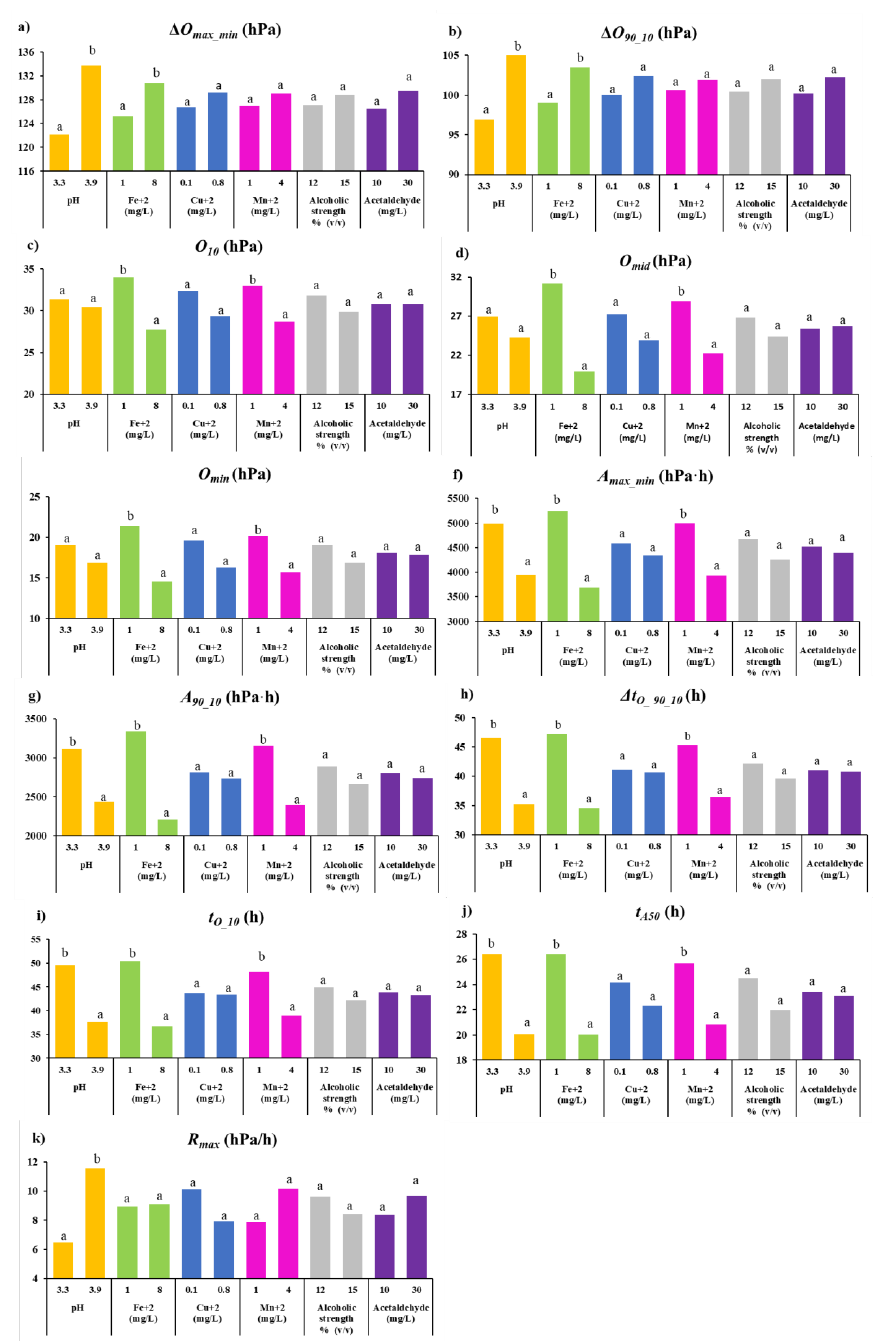
Figure 2. Graphical representation of average value of each parameter of the oxygen consumption kinetics for each concentration level of the different input parameters used for reconstitution. For the same color, different letters indicate significant differences between different values or concentrations of reconstitution input parameters according to Fisher’s LSD test ( p < 0.05). ( a ) ∆ O max_min : total oxygen consumed (hPa); ( b ) ∆ O 90_10 : variation between oxygen 90% and oxygen 10% (hPa); ( c ) O 10 : oxygen value that represents 10% of the range between the maximum and minimum values (hPa); ( d ) O mid : oxygen at half consumption time(hPa); ( e ) O min : minimum/finaloxygenvalue(hPa); ( f ) A max_min : areaundertheoxygenconsumption curve (hPa · h); ( g ) A 90_10 : area under the oxygen consumption curve and between t O_90 and t O_10 (hPa · h); t O_10 : time when O 10 is reached; ( h ) ∆ t O_90_10 : time variation between t O_90 and ( i ) t O_10 ; ( j ) t A50 : time when the area under the kinetic curve is half the total area under the curve (h); ( k ) R max : maximum value of the oxygen consumption/rate curve